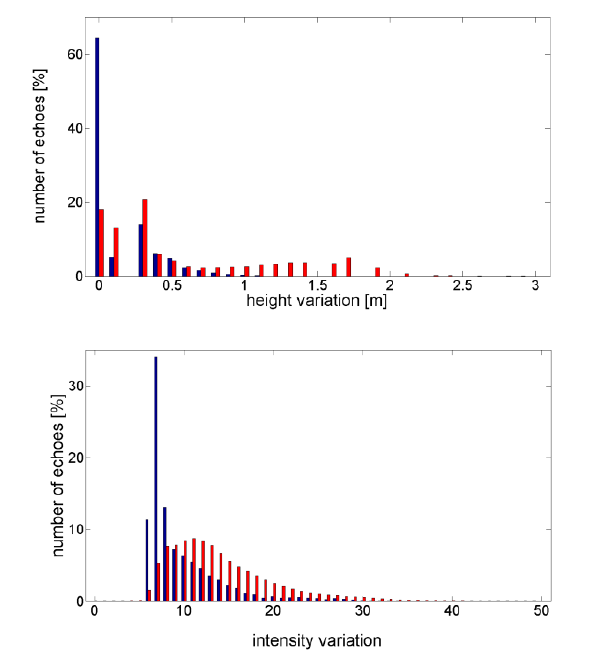
Figure 9: Distribution of features height variation (a) and intensity variation (b) for water (blue) and land